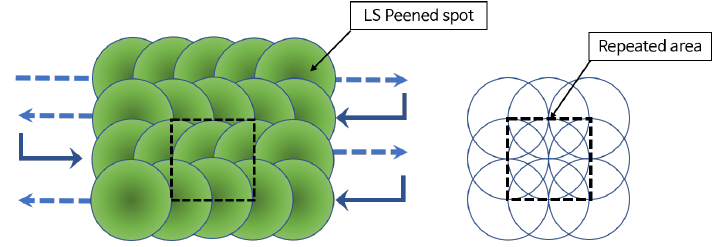
Figure 3. Example of the overlapped multiple LSP pattern.